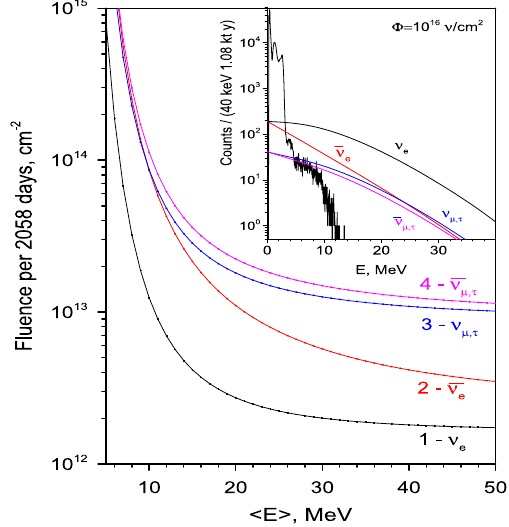
Fig. 8 The same as in Fig. 7, but for the supernova spectra. The inset shows the expectedelectronrecoil spectrafor the case (cid:10) E (cid:11) = 15 . 6 MeV The region of the neutrino energy up to 50 MeV was cho- sen in accordance with the characteristic energies of neutri- nos appearing in the pion decay at rest. A sharp decrease in sensitivity to the neutrino fluence at the energies below 17 MeV occurs when the neutrino energy enters the 13.6– 16.8 MeV interval. At higher energies, the limit becomes almost constant since the (ν, e ) -scattering cross section is proportional to E ν and the spectrum of recoil electrons weakly depends on the electron energy (Fig.